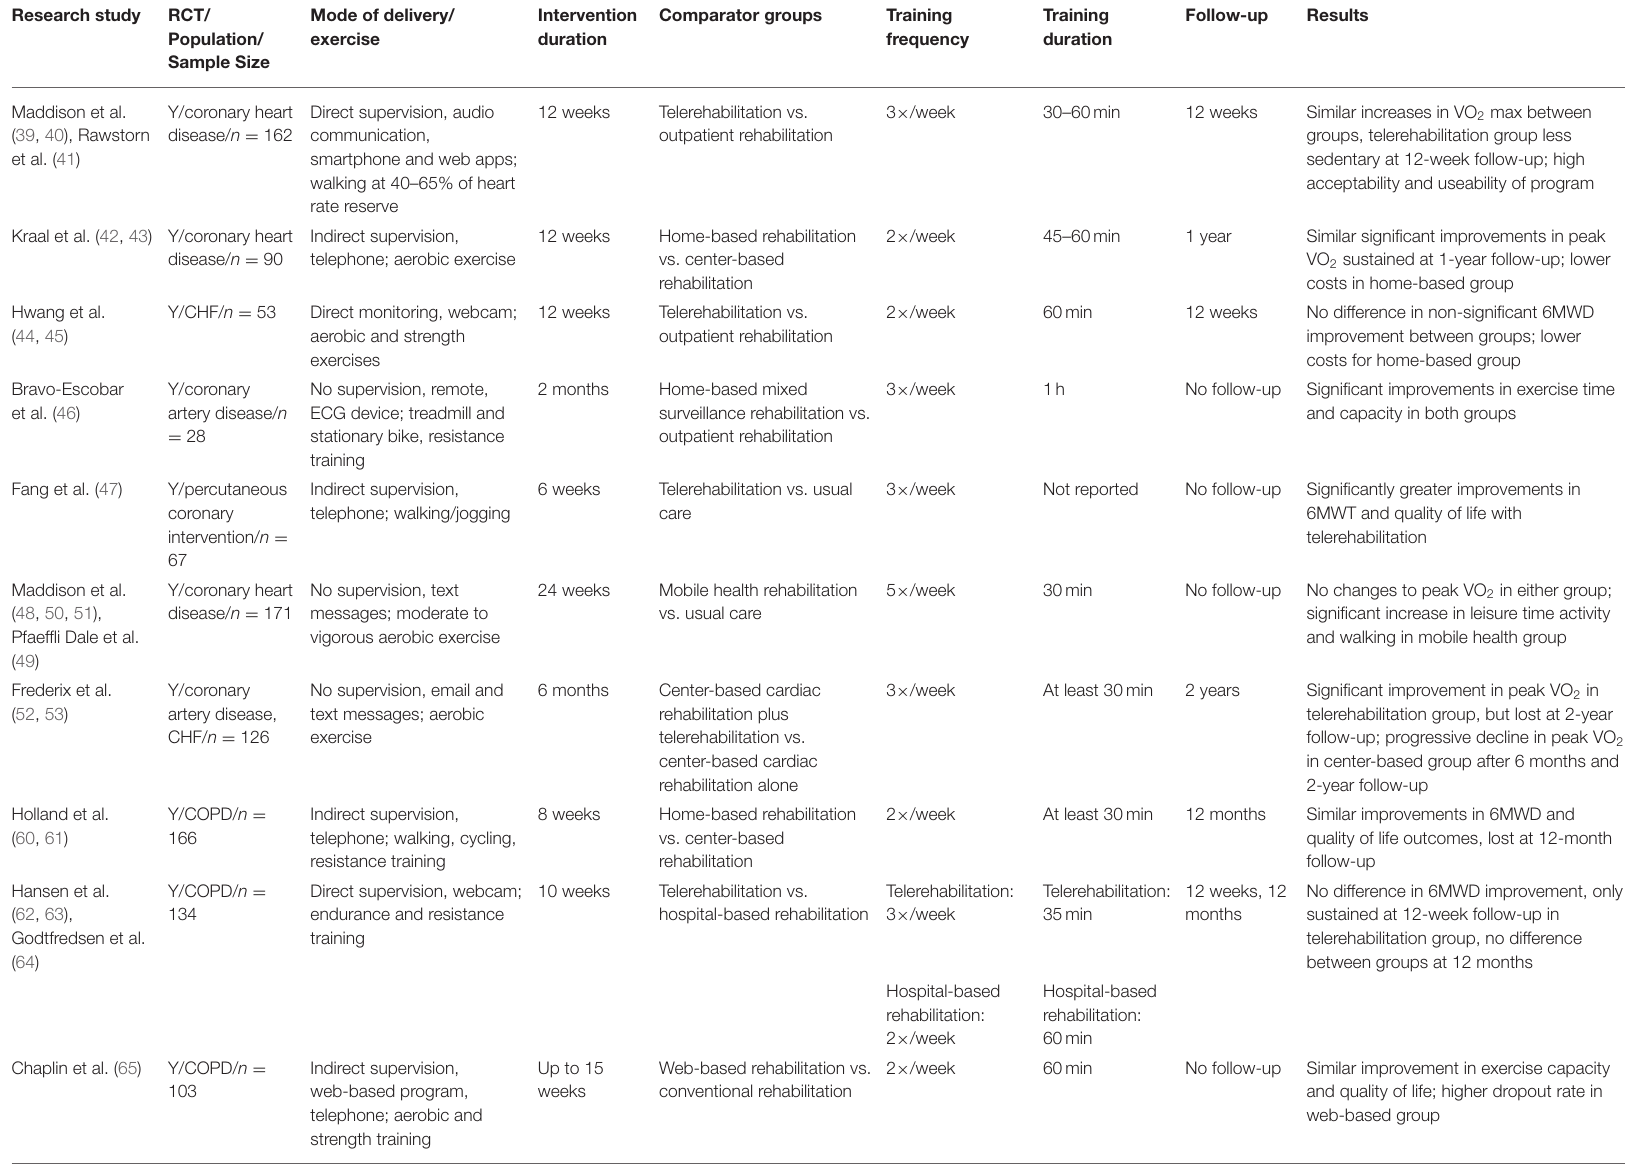
TABLE 2 | Characteristics and outcomes of home-based tele-exercise studies—cardiorespiratory. Research